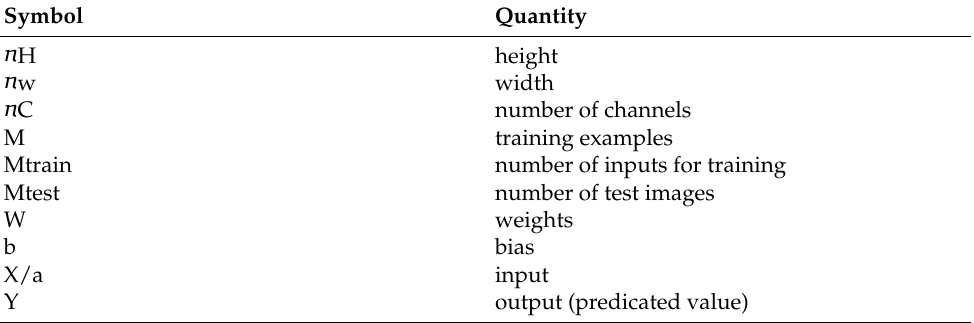
Table 1. Units for notation.